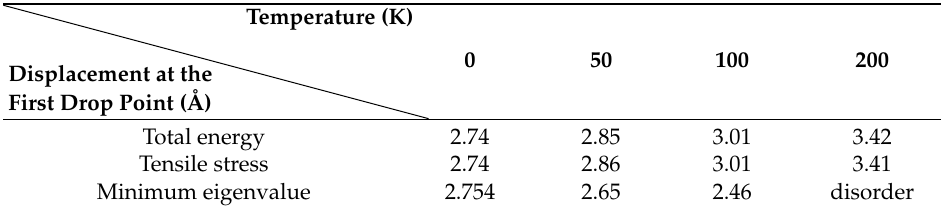
Table 1. Displacement at the first drop point of energy, stress, and minimum eigenvalue at different